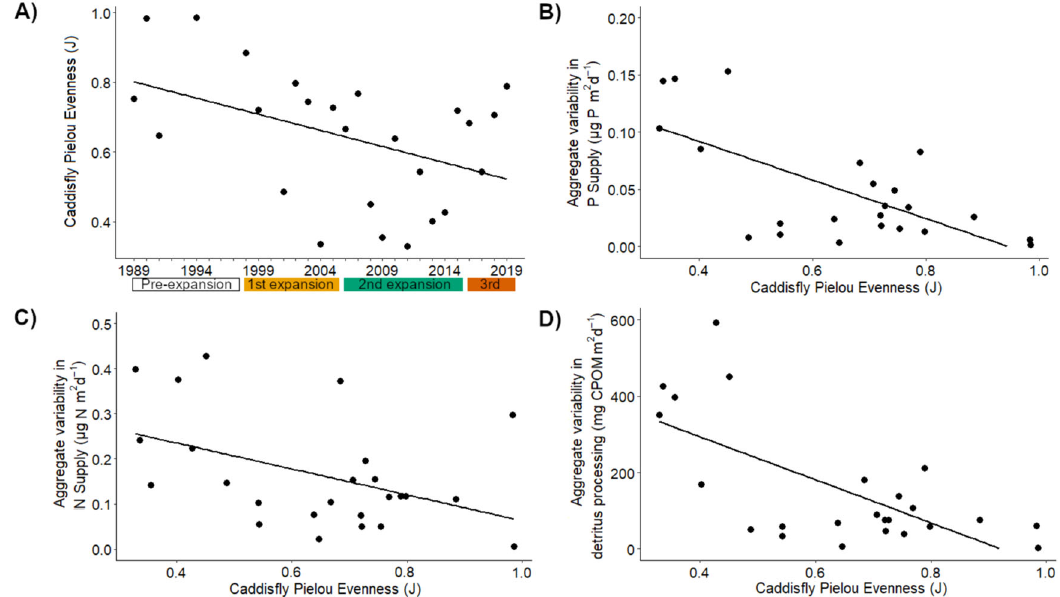
Fig. 4 Relationships between caddis fl y assemblage evenness and aggregate variability in species contributions to ecosystem processes. Pielou ’ s Evenness (J) was calculated using average caddis fl y densities across all permanent ponds at Mexican Cut (e.g., densities in Fig. 2A; averages of = 3 – 7 ponds per year). Aggregate variability in species contributions to ecosystem processes (e.g., variability among ponds and species) was calculated as the sum of species ’ among-pond variance in process contribution and 2× the sum of contribution covariances among all species pairs. Aggregate variability was square root transformed to achieve normality for statistical analysis. This transformation also returns aggregate variability to the original units of the ecosystem process, corresponding to units of total contributions in Fig. S1A – C. Colored boxes under ( A ) x -axis indicate range expansion periods de fi ned by initial dates of upslope range expansions (e.g., orange fi rst range expansion box indicates L. picturatus arrived in 1998, green for G. lorretae and red for N. hostilis in 2016). Evenness declined over time (( A ); F 1,17 = 5.73, p = 0.029, R 2 = 0.20) but did not differ among or change during range expansions (expansion: F 3,17 = 1.74, p = 0.20; expansion × year: F 3,17 = 0.72, p = 0.55). All three ecosystem processes ’ aggregate variability had negative relationships with evenness (P in ( B ): F 1,23 = 17.61, p < 0.001, R 2 = 0.42; N in ( C ): F 1,23 = 5.74, p = 0.025, R 2 = 0.17; detritus in ( D ): F 1,23 = 17.83, p < 0.001, R 2 =